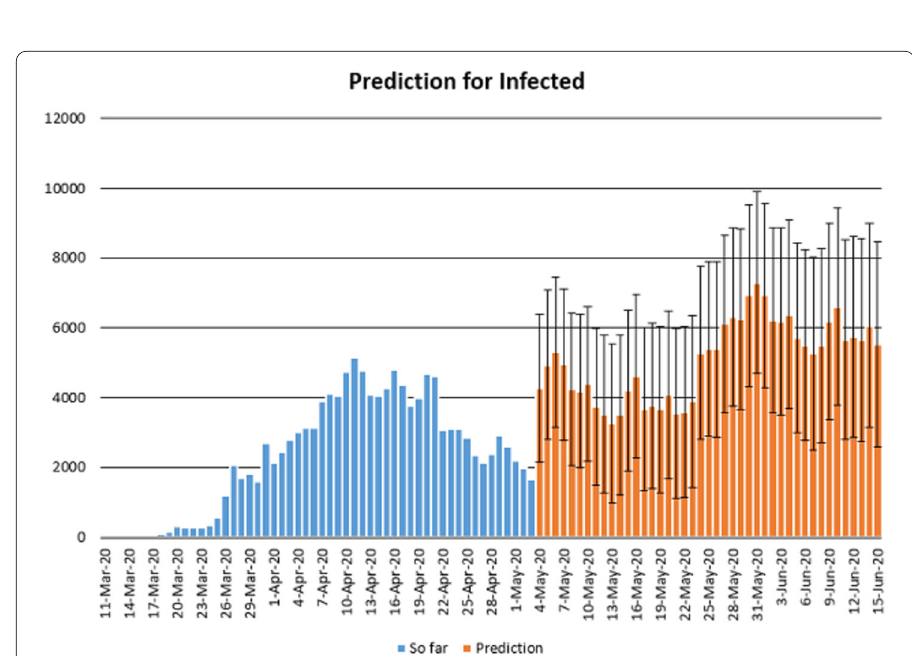
Figure 18 Prediction of daily number of infected in Turkey using forecast sheet with reliability level of